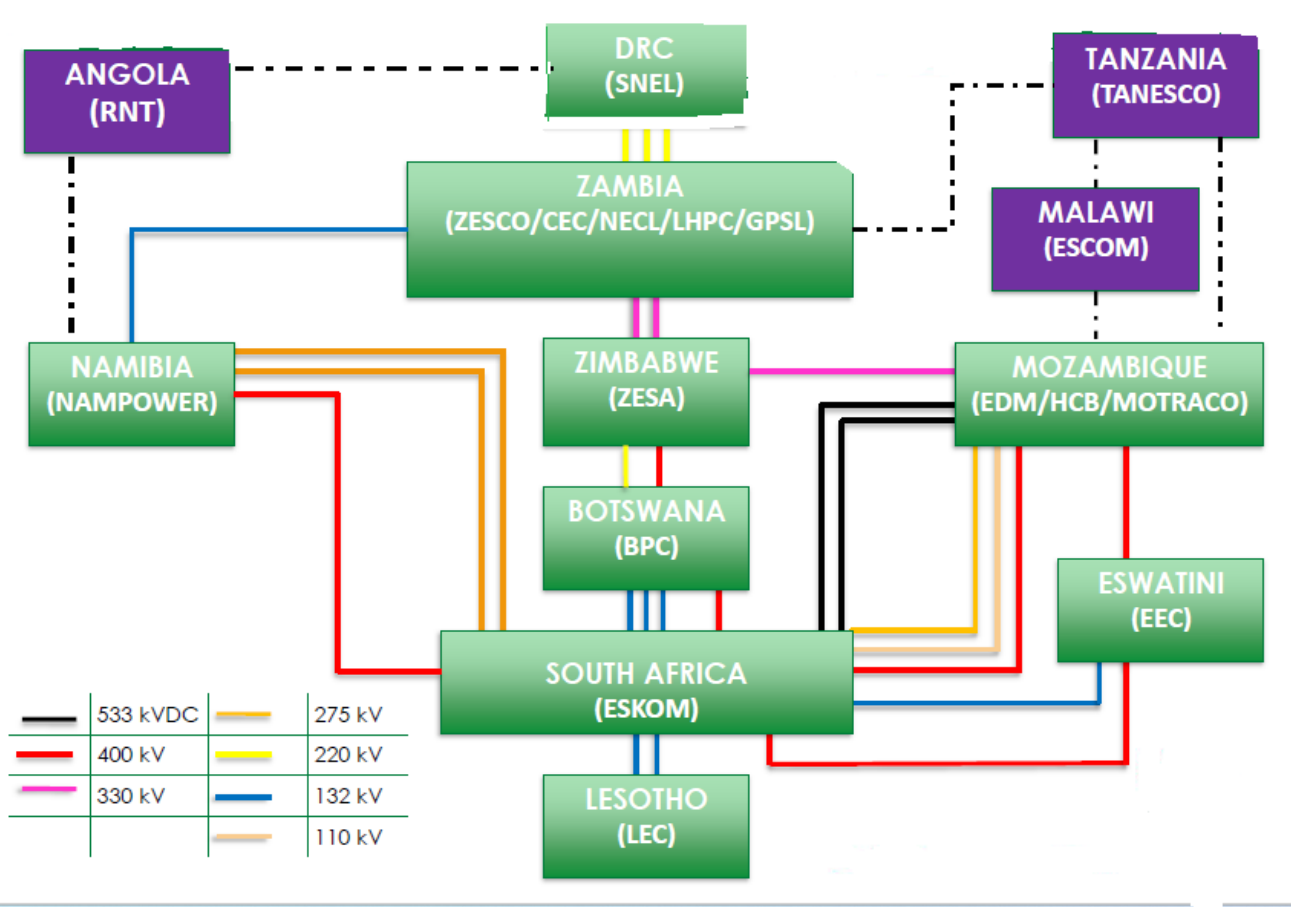
Figure 1. Existing and future interconnections of the SAPP.